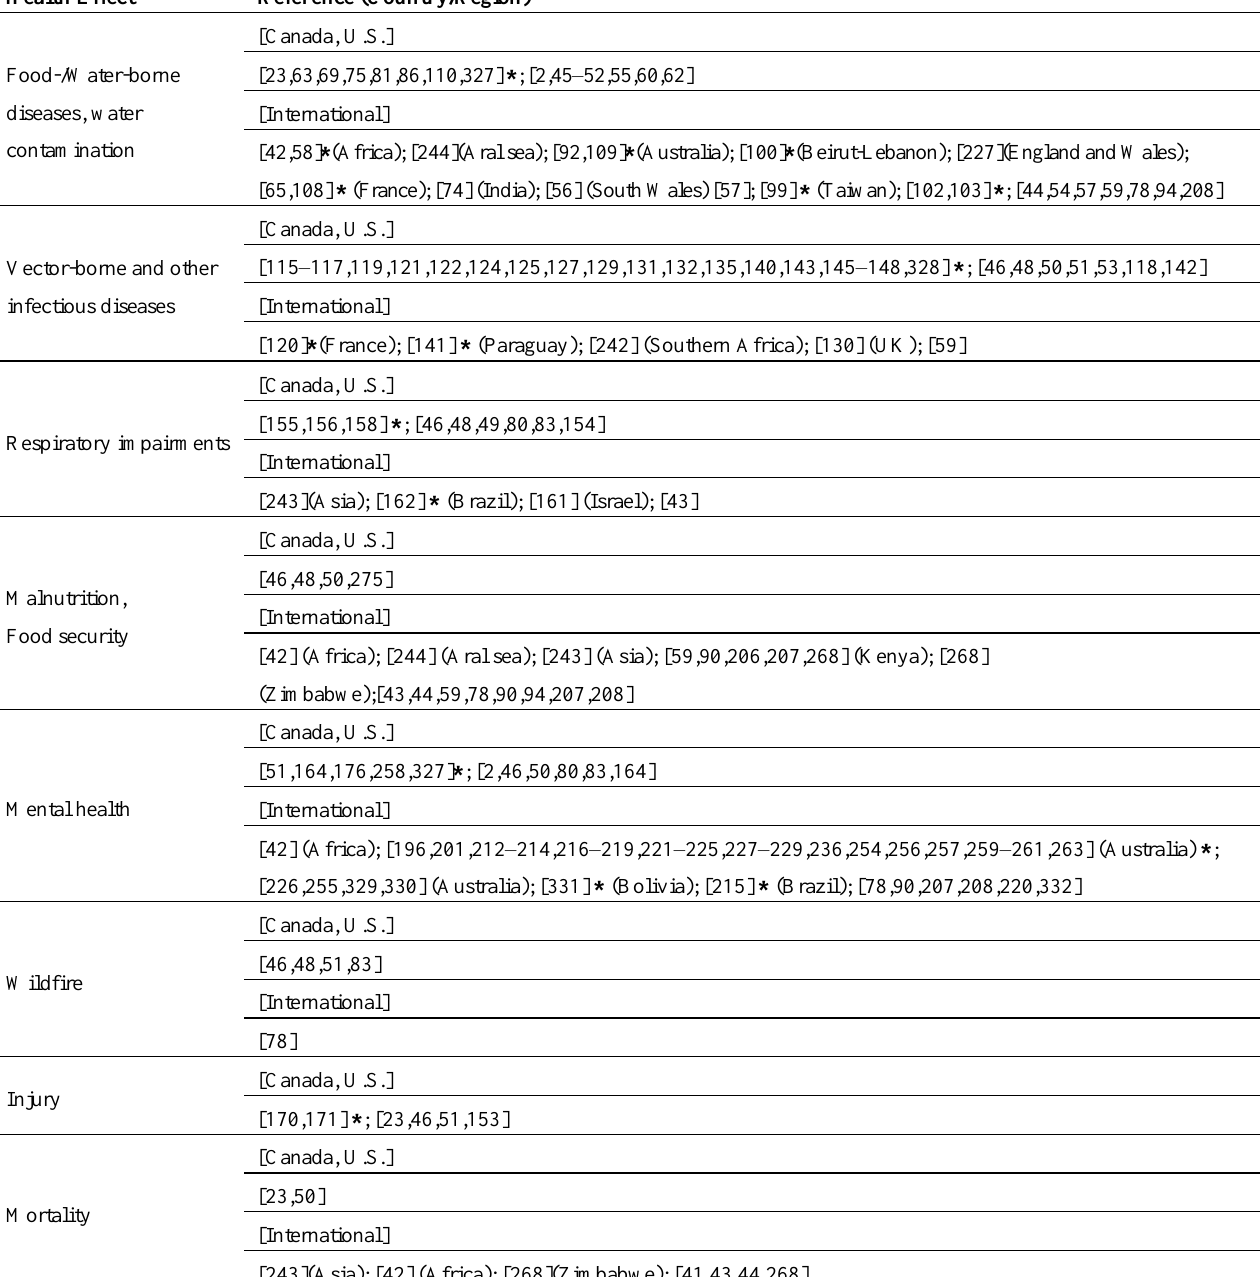
Table A1. Health effects of